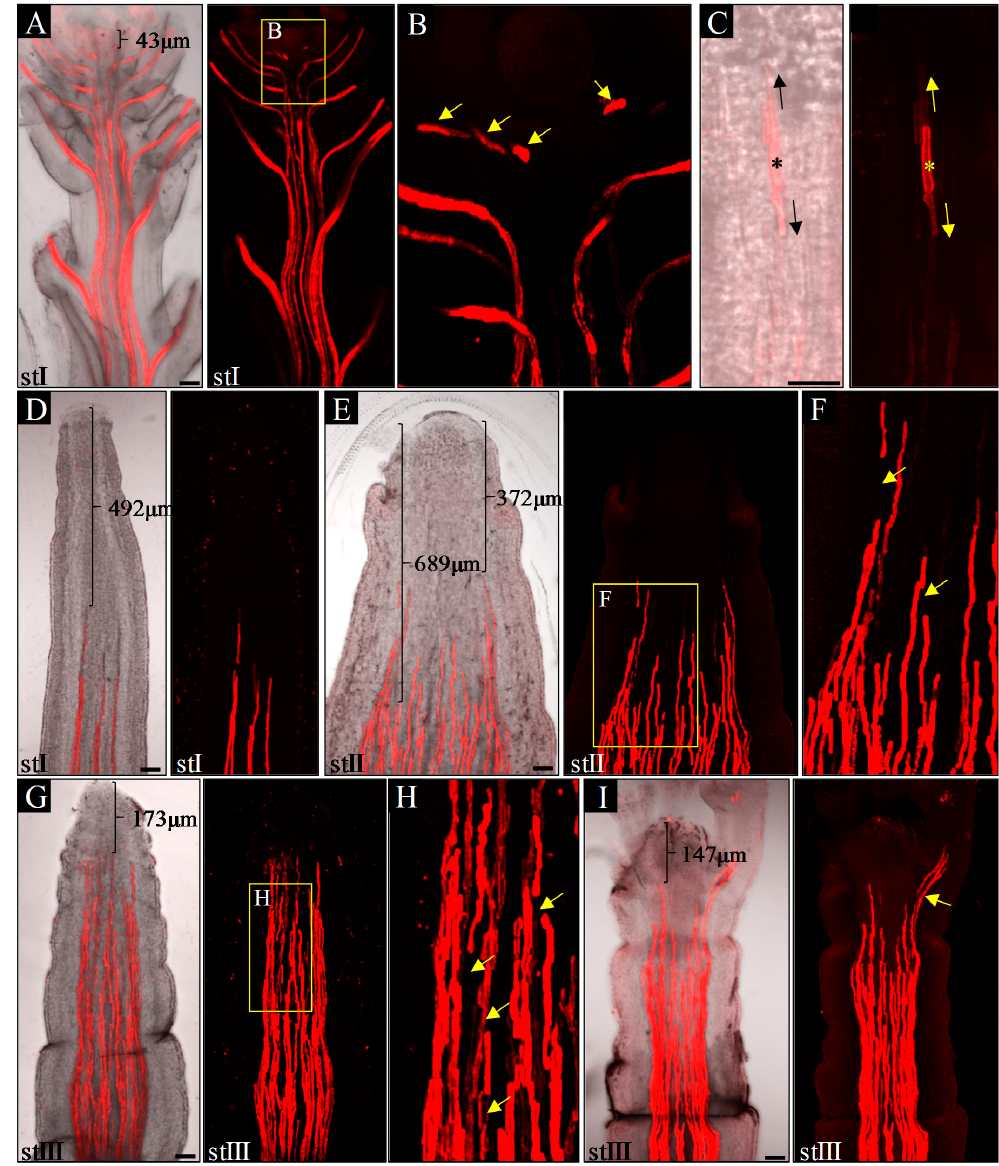
Figure 3. Structure of the xylem strands in the apices of the inflorescence stems, stained with propidium iodide. In WT plants, xylem strands differentiate close to the meristem—distance denoted with bracket, and are continuous in the mature stem and organs ( A ); discontinuities (denoted with arrows) are present only in the apical, meristematic region of the shoot ( B ). The discontinuities in the xylem strands, however, disappear during development, as a result of bidirectional xylem differentiation—denoted with arrows ( C ). pin1 mutants are characterized by: discrete, continuous xylem strands differentiating far from the meristem (distance denoted with brackets), in stage I ( D ); increased number of xylem strands, in comparison to stage I, with variable distance from the meristem—denoted with brackets ( E ) and with local discontinuities—denoted with arrows ( F ), in stage II; numerous differentiated xylem strands close to the meristem—distance denoted with bracket ( G ), with frequent discontinuities—denoted with arrows ( H ), and developing malformed organs with their own xylem strands connected to the strands of the main stem—denoted by arrow ( I ), in stage III. St I–III—successive developmental stages, the asterisk—first differentiated protoxylem element. Scale bar 50 μ m.